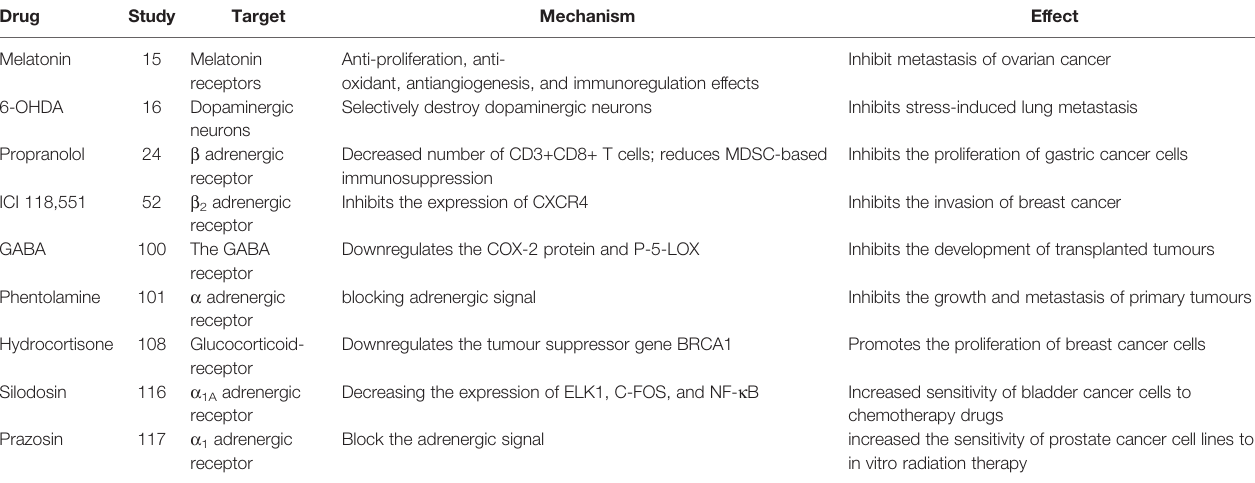
TABLE 2 | Drugs targeting the neuroendocrine system and immune system.